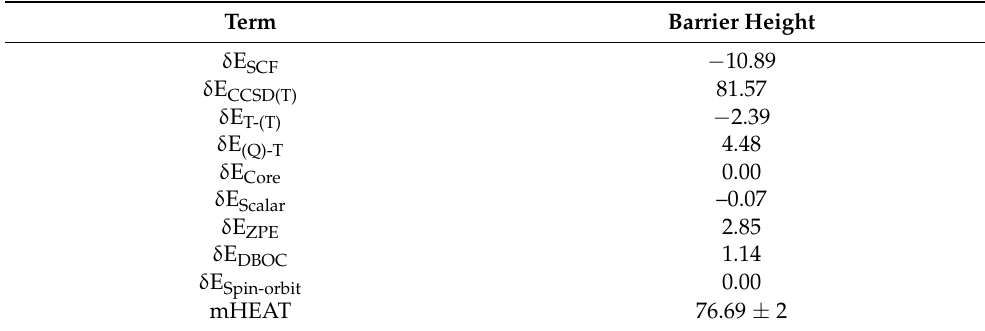
Figure 1. Schematic reaction energy profile for the reaction of NO 3 radical with H 2 calculated using the G3B3 (in black) and mHEAT (in red) methods. The conformation for the transition state calculated with the G3B3 is also presented in the graph. Bond lengths are given in Angstrom (Å) while angles are in degrees. Table 1. Individual contributions (kJ mol − 1 ) of various terms to the total barrier height of the TS calculated at 0 K using the mHEAT-345(Q)